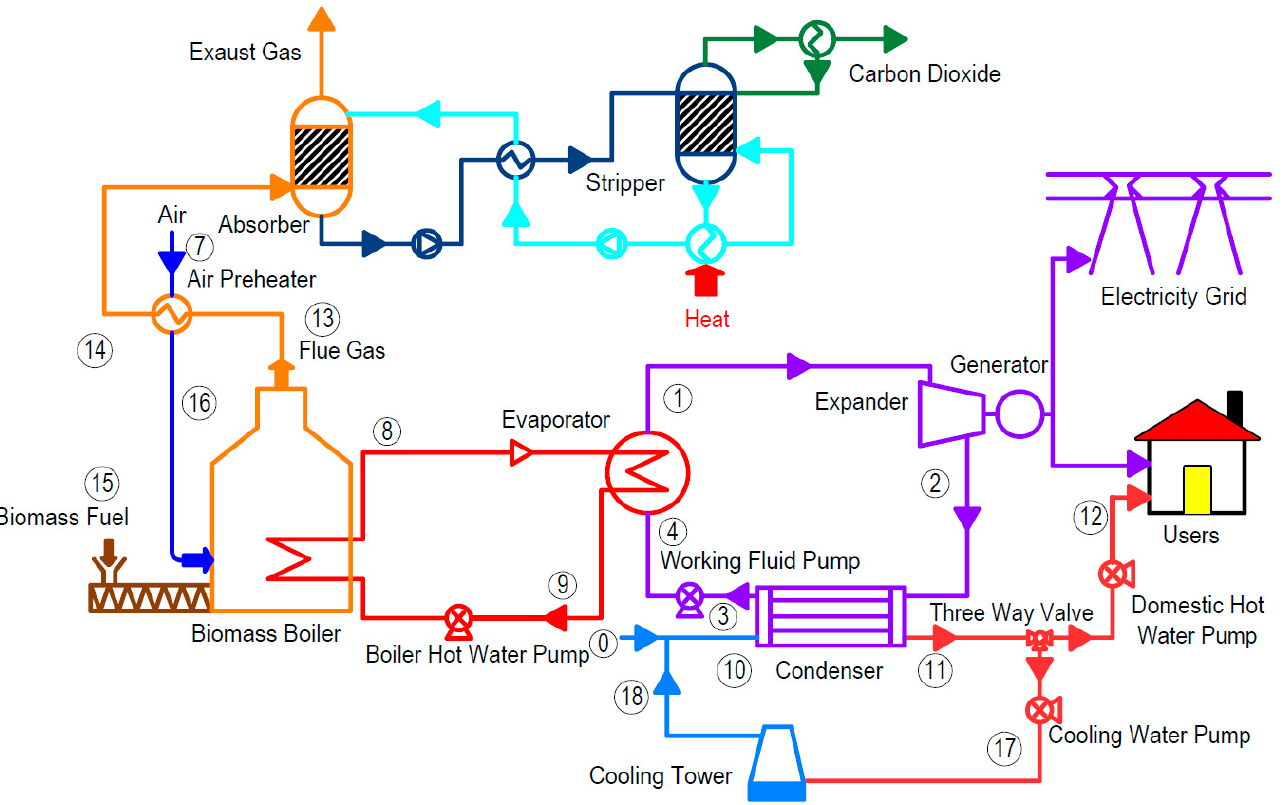
Figure 10. Schematic process flow diagram of biomass-fired ORC-CHP system with MEA-based CC (adapted from [102]).